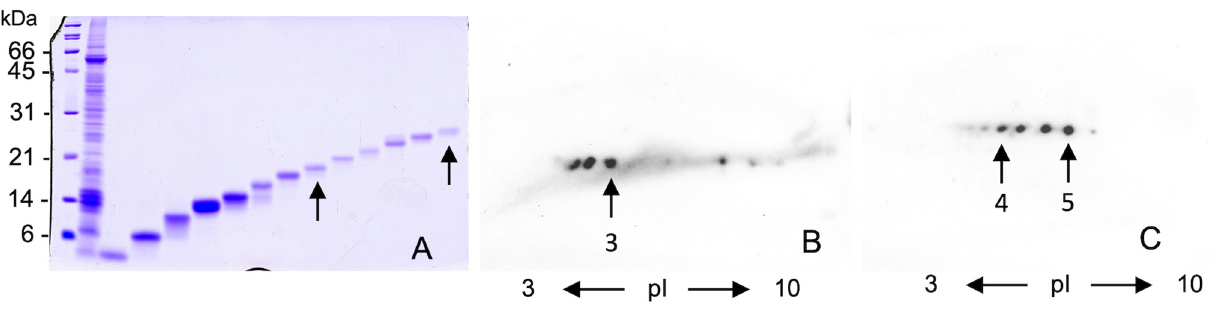
Figure 3. Panel ( A ): 16% SDS-PAGE, Lane 1: MW markers; lane 2: total WSSP, lanes from 3 to 15: fractionated WSSP by electroendosmotic preparative gel electrophoresis. The arrows indicate the fractions resolved by 2-DE and IgE-Blotting (panel ( B , C ) respectively). Arrow (3) in panel ( B ) indicates the spot identified as 16.9 kDa class I heat shock protein 1, while the two arrows in panel ( C ) indicate the spots identified as triosephosphate isomerase (4) and thioredoxin peroxidase (5), respectively.